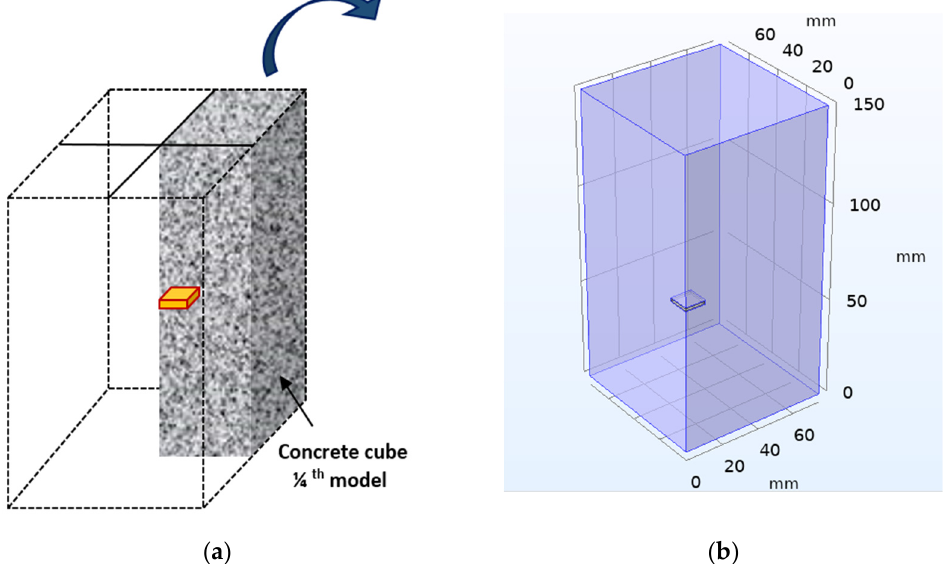
Figure 7. Concrete cube with embedded PZT sensor: ( a ) The schematic one-fourth model; ( b ) Two- axis symmetry 3D model.